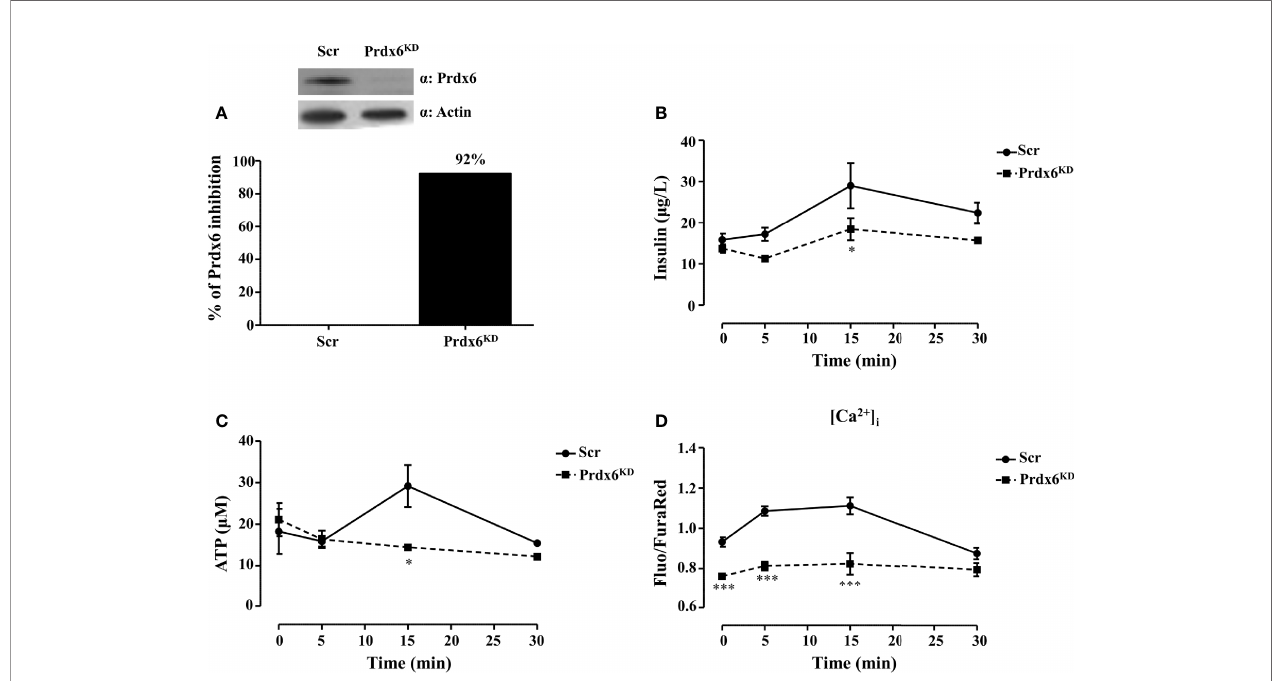
FIGURE 1 | Prdx6 deletion alters insulin secretion and ATP production. (A) Prdx6 expression in the insulinoma b TC6 cell line stably silenced with lentiviral shRNA for Prdx6 (Prdx6 KD , black bar) or for GFP (Scr, white bar). Steady-state levels of Prdx6 were analyzed with immunoblotting. The bar graph showed the ef fi ciency of Prdx6 silencing reported as the percentage of inhibition of Prdx6 expression in Prdx6 KD cells following viral infection. (B) Insulin secretion was evaluated after high- glucose (30 mM) stimulation at different time points in Prdx6 KD (black- fi lled square) and Scr cells (black- fi lled circle). (C) ATP production was evaluated at different time points in Prdx6 KD (black- fi lled square) and Scr cells (black- fi lled circle). (D) Calcium content was assessed in Prdx6 KD (black- fi lled square) and Scr cells (black- fi lled circle) with or without glucose 30 mM. Values are expressed as mean ± SEM. *p < 0.05, ***p < 0.001 (n = 5). a.u., arbitrary